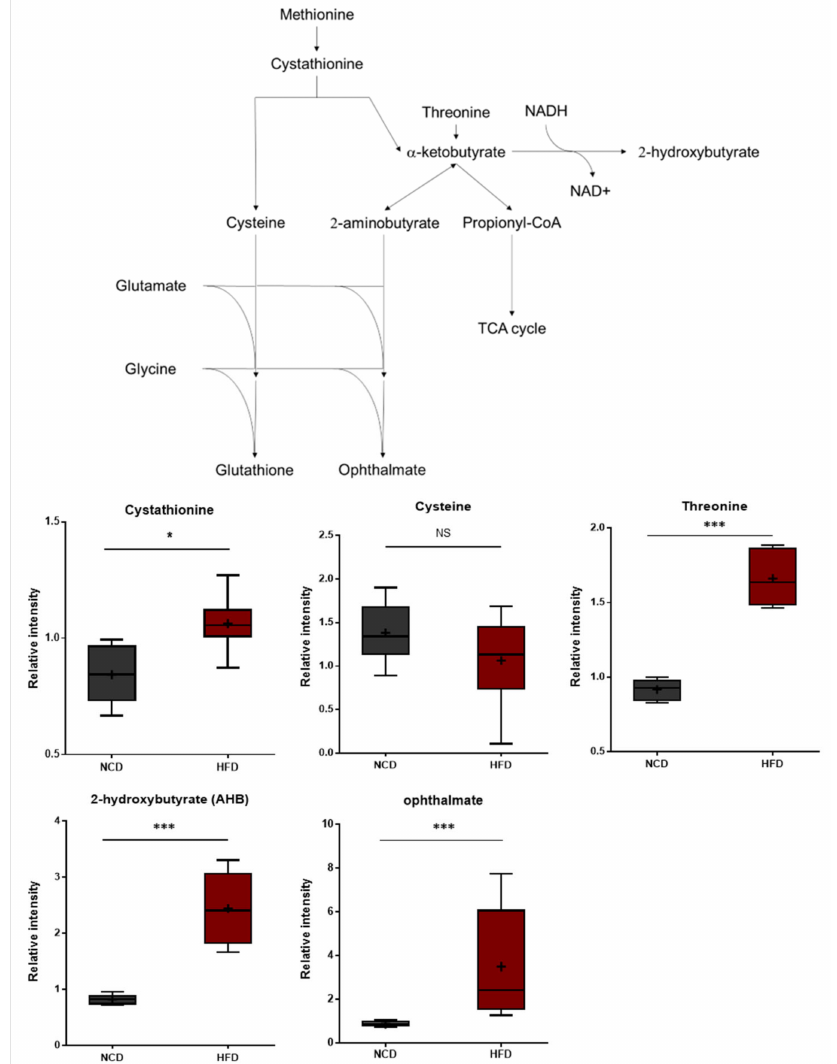
Figure 4. Pathway statistically significant biochemical profiled between NCD group and HFD group. In methionine, the cystenine–glutathione metabolism pathway leads to AHB and ophthalmate production increased in the HFD group which shows increased oxidative stress within cells. Data were presented as mean ± SD ( n = 6) and two-way ANOVA with Bonferroni’s multiple comparison test. * p < 0.05; *** p <